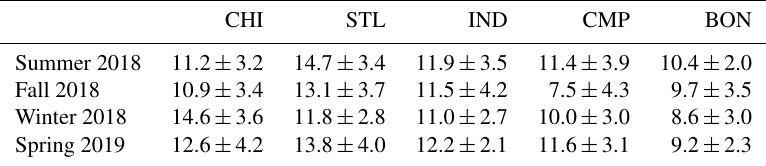
Table 2. Seasonal averages ( ± standard deviation) of PM 2 . 5 mass concentrations (unit: µgm − 3 ) at our sampling